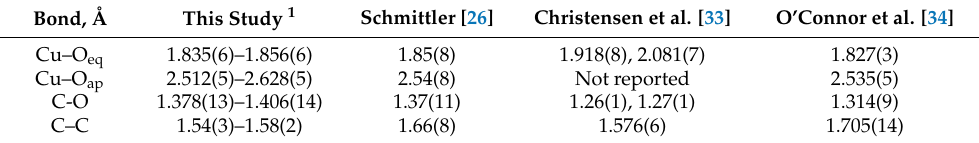
Table 2. Bond distances (Å) in the structural model of Cu oxalates presented in the current study and from the literature